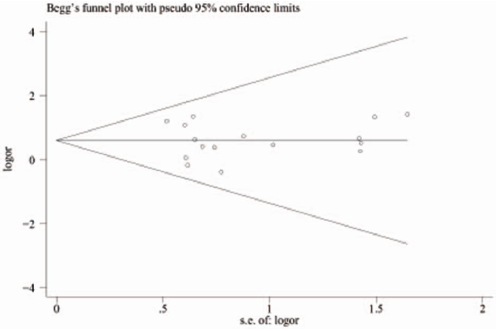
Figure 3. Begg’s funnel plot of publication bias test of all preeclampsia associated with the prothrombin G20210A polymorphism. LogOR means nature logarithm of OR (odds ratio). Horizontal line means the summary estimate, while the sloping lines mean the expected 95% confidence interval.